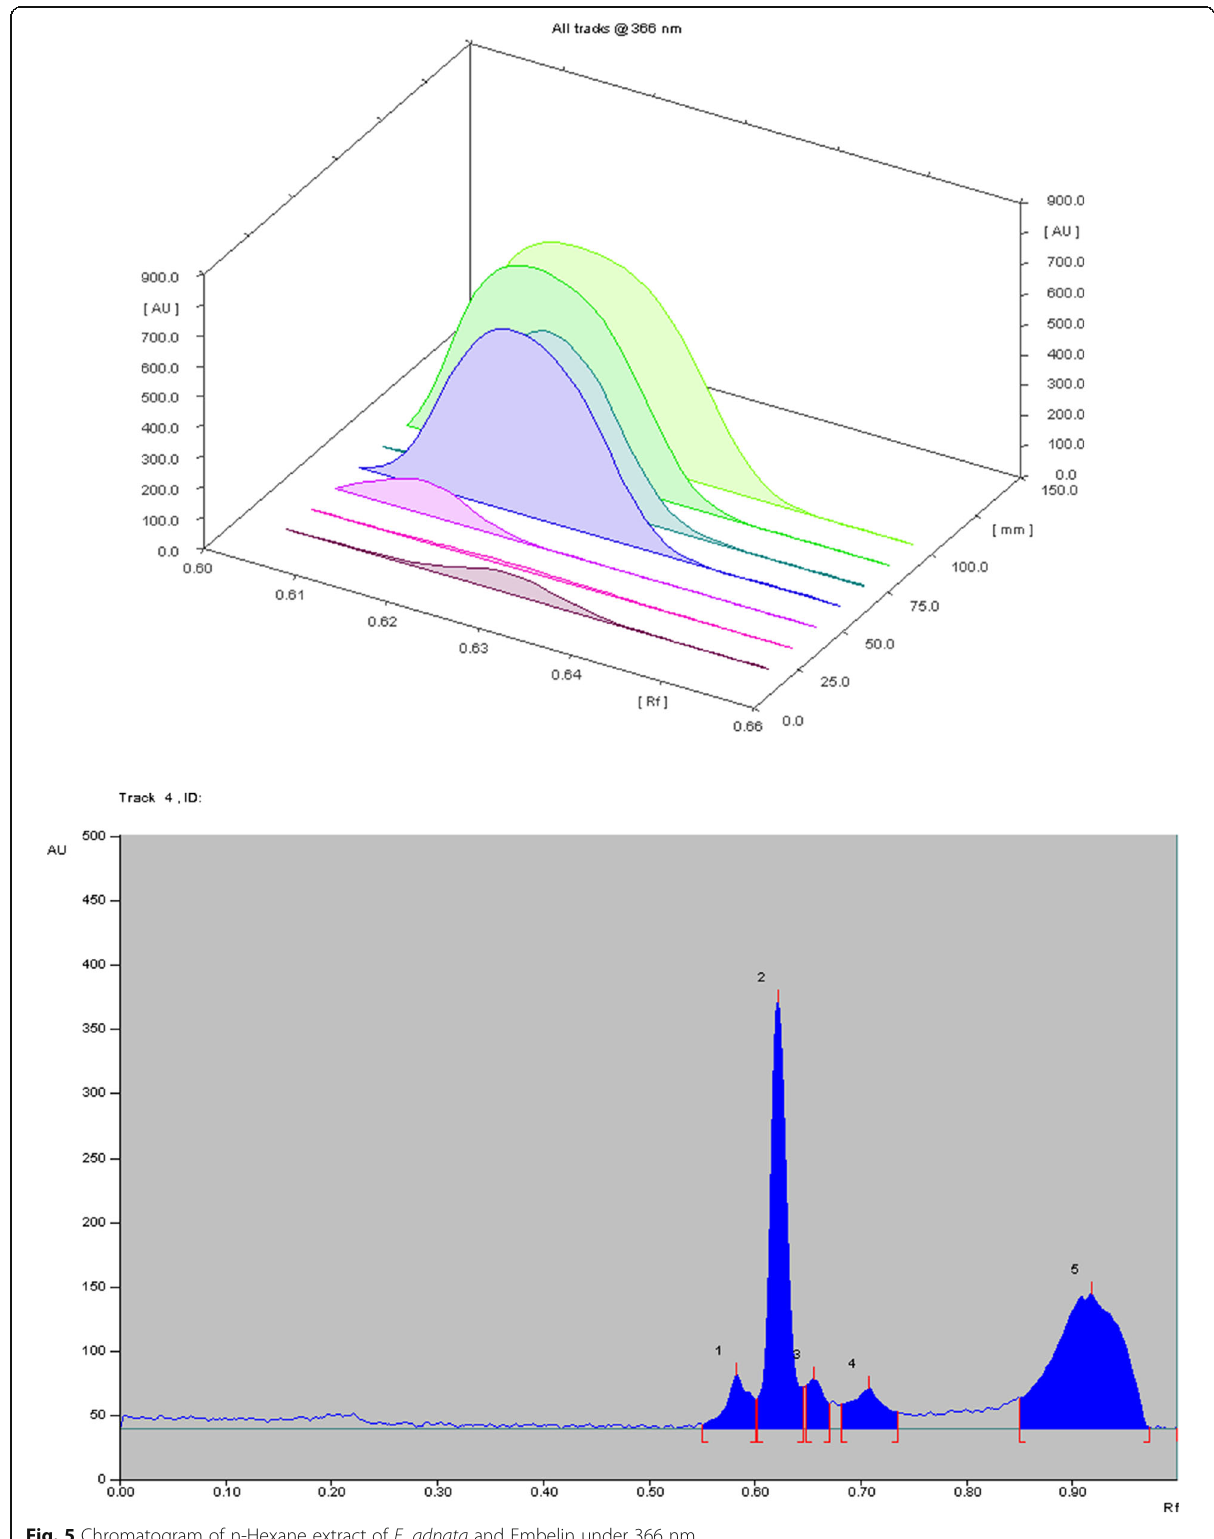
Fig. 5 Chromatogram of n-Hexane extract of E. adnata and Embelin under 366